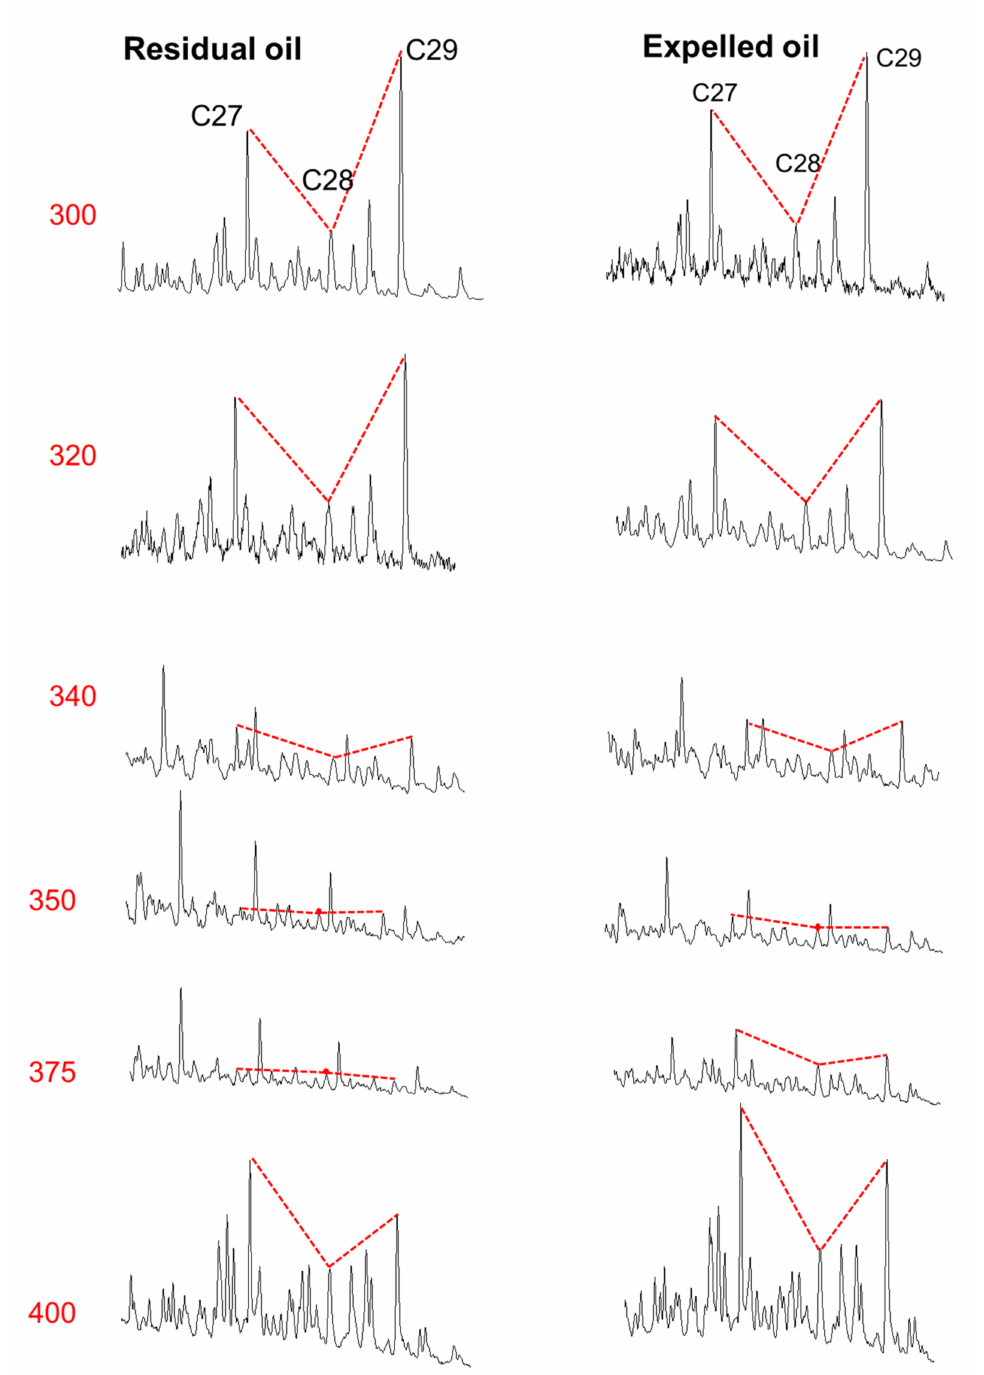
Figure 13. The C27-, C28-, C29- sterane distributions in residual oil and expelled oil, showing variations with pyrolysis temperatures. Note that the peak width of C29- steranes was greater than that of C27- steranes and so C27- steranes seem more abundant than is actually the